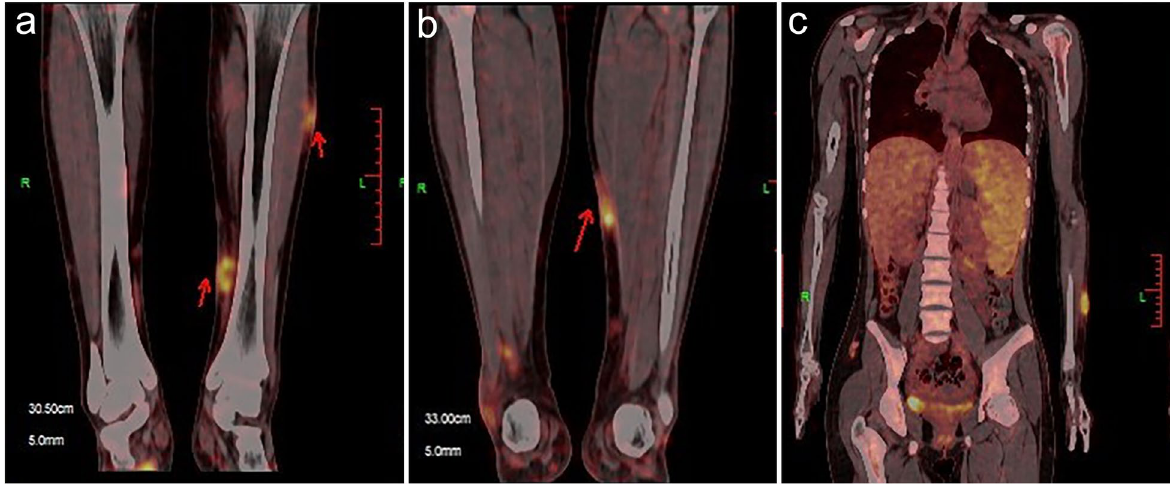
Fig. 2 After completing a biopsy of the entire nodule in the right arm of the patient, PET-CT showed increased FDG metabolism in a-b) the Bilateral lower extremities and feet subcutaneous, the right medial-posterior knee muscle group, the left posterior muscle group, and c) the left forearm and spleen, with the highest located at the right knee muscle group and a SUVmax of 8.6